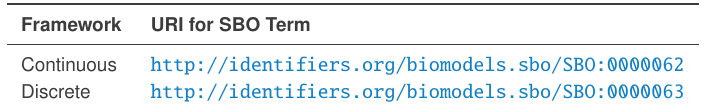
Table 9: SBO terms to specify the framework property of a Model